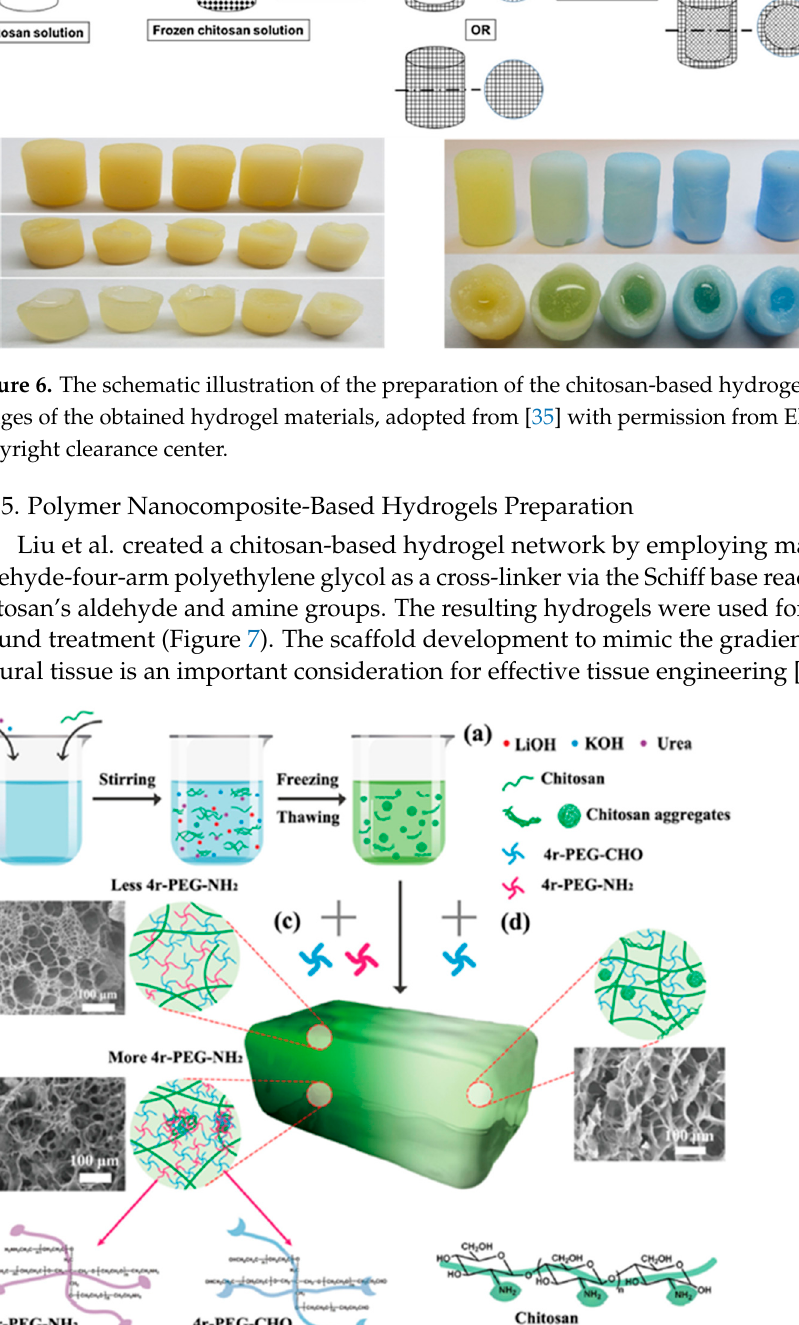
Figure 7. The schematic representation with respect to the synthesis and structure of Cn nm gels. ( a ) The dissolution process of chitosan in alkaline solution; ( b ) The structure of gels with only 4r- ( c ) The structure of gels with only 4r-PEG- CHO; ( d ) The structure of gels with 4r-PEG-CHO and 4r-PEG-NH2; ( e ) The molecular structure of the reactants. The SEM image on the right belongs to C2-N0 gel, the SEM images on the top left and bottom left belong to C2-N2 gel and C2-N4 gel, respectively, adopted from [36] with permission from Elsevier through copyright clearance center. PEG: